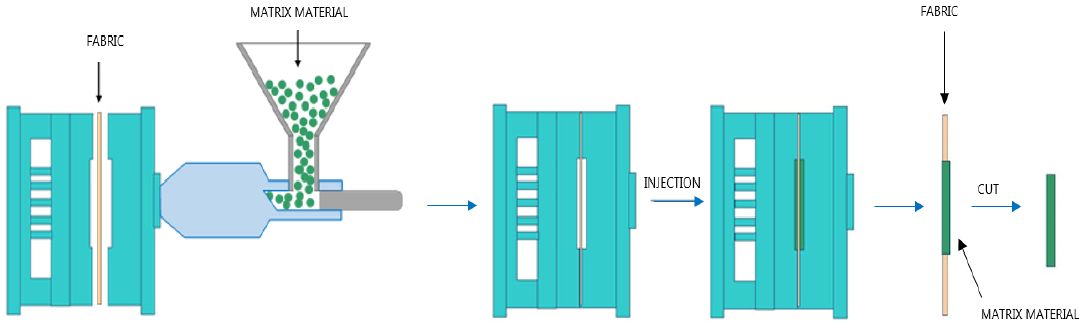
Figure 4. Injection over-moulding process sketch.